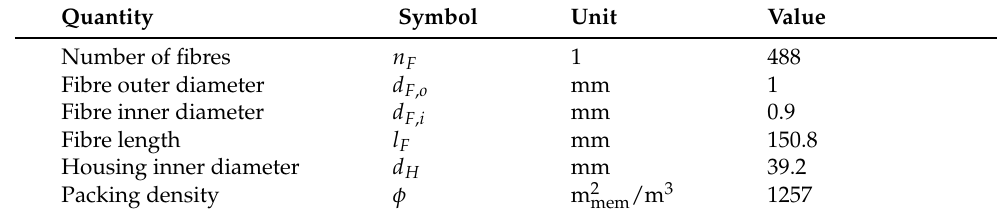
Table 1. Measured geometric parameters of the hollow fibre membrane humidifier.